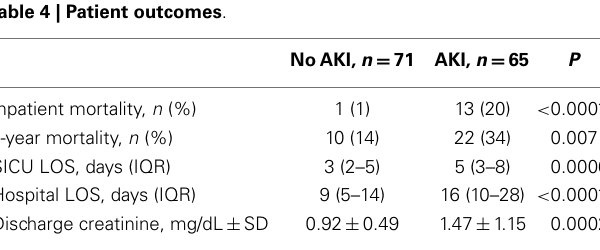
Table 4 | Patient outcomes